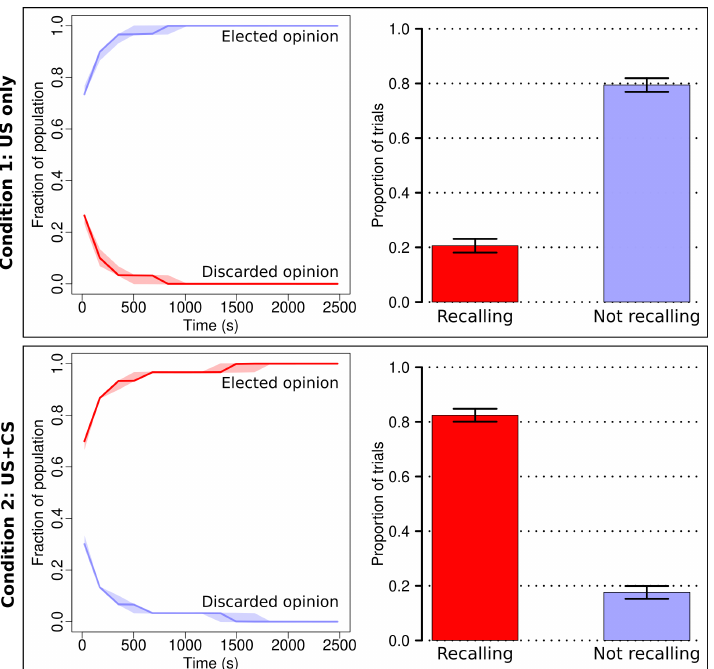
Figure 12. Outcome of the testing phase in the Pavlov experiment ( n = 1000 trials, group of 30 robots). Left plots show the dynamics of the quorum and how the majority opinion is gradually propagating until the whole group has made a collective decision (median ± 95% CI). Right plots show the response advertised by the group resulting from the quorum and in response to the conditional stimulus (CS) in the testing phase. The results show that, when the group is trained with the unconditional stimulus (US), it does not recall information in the testing phase in 79% of the trials. However, when the group is trained with the unconditional and the conditional stimuli together, it learns to associate the two stimuli and recalls the association during the testing phase, providing a positive response in 82% of the